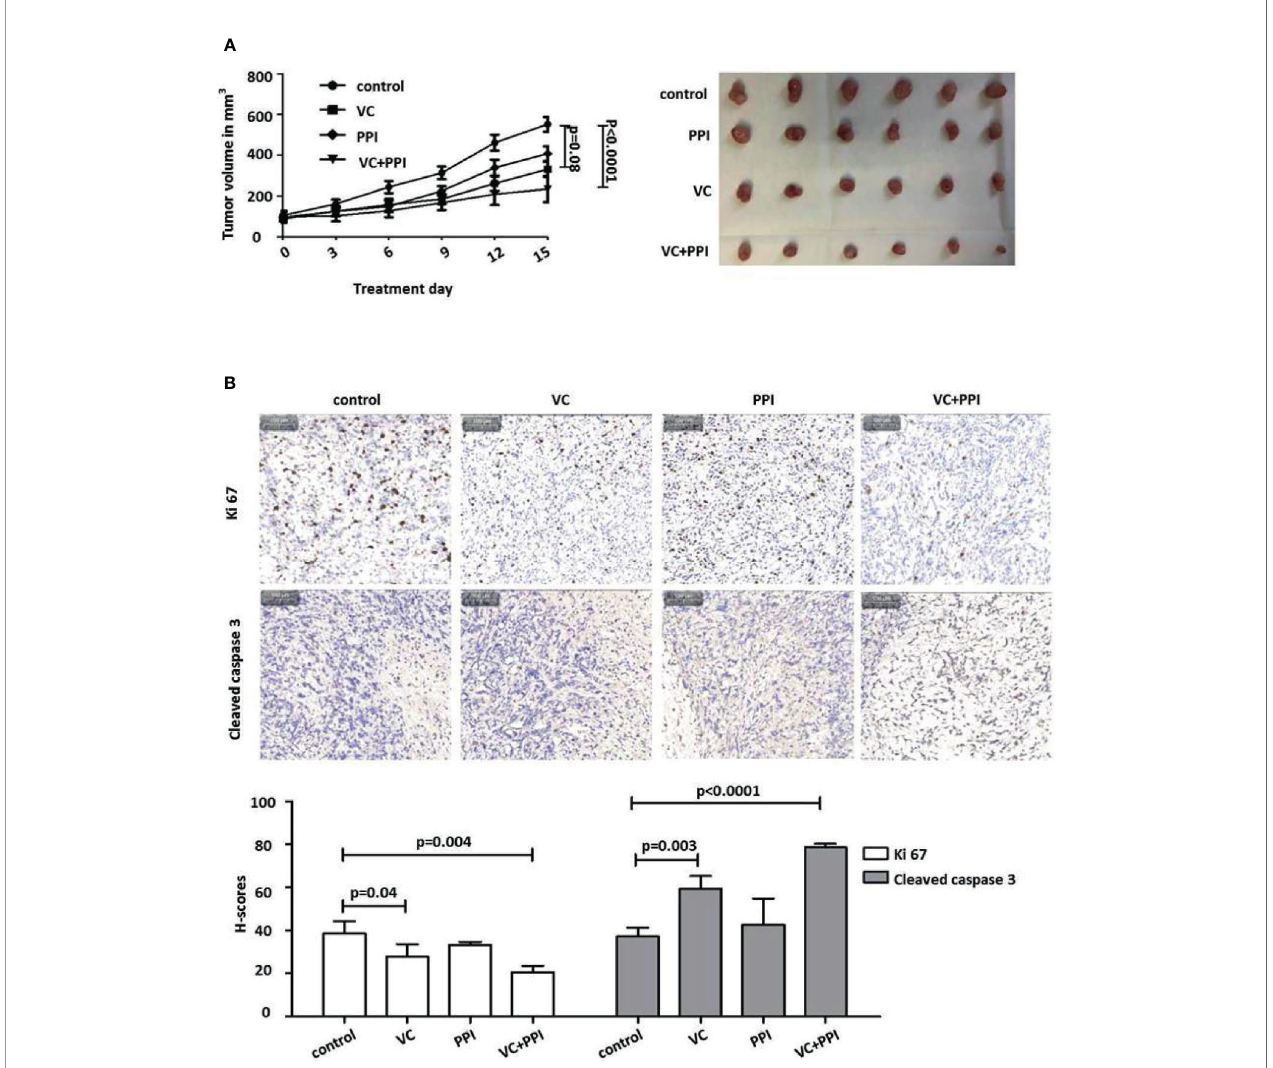
FIGURE 5 | Pantoprazole enhances the anticancer effect of vitamin C in mice bearing subcutaneous PC3 xenografts. (A) BALB/c nude mice (n=24; 4-6-week-old males) were subcutaneously injected with 5×10 6 PC3 cells. When the tumor size had reached 100 mm 3 , pantoprazole (PPI, 200 mg/kg, daily) and vitamin C (VC, 4 g/kg, twice daily) were injected intraperitoneally into the mice. After 15 days, all mice were euthanized, the remaining tumors were removed, and their volumes were measured. In the combined treatment group (VC + PPI), pantoprazole was given one day before injection of vitamin C. Left: tumor growth curves (day 0 – day 15) after the respective treatments; right: tumors prepared from the six different mice from each treatment group (control, PPI, VC, VC + PPI) after sacri fi ce (day 15). (B) Immunohistochemical (IHC) analysis of the proliferation marker Ki67 and the apoptosis marker cleaved caspase-3 in explanted tumors (upper panel). The grey bar in the upper left corner of each picture represents 100 µm. The lower panel shows semiquantitative analysis of the IHC results using H-scores as described in the Methods section. Quanti fi cation of the IHC results demonstrated a signi fi cant decrease (p = 0.004) in expression of the proliferation marker Ki67 and a signi fi cant increase (p < 0.0001) in expression of the apoptosis marker cleaved caspase 3 in VC + PPI-treated cells compared to controls, respectively. The bars represent the mean and SD of the mean of n ≥